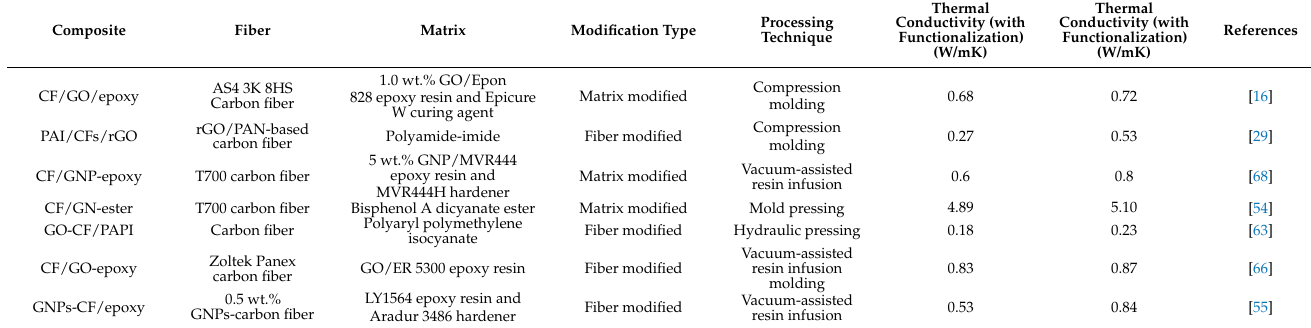
Figure 10. Thermal conductivity of cracked and uncracked carbon fiber-reinforced composites [29]. Obtained with permission from Composites Part B: Engineering; published by Elsevier, 2019. Table 2. Listed thermal conductivity of CFRPs with